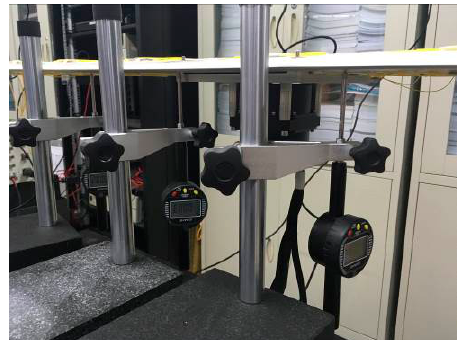
Figure 16. Micrometer working diagram.